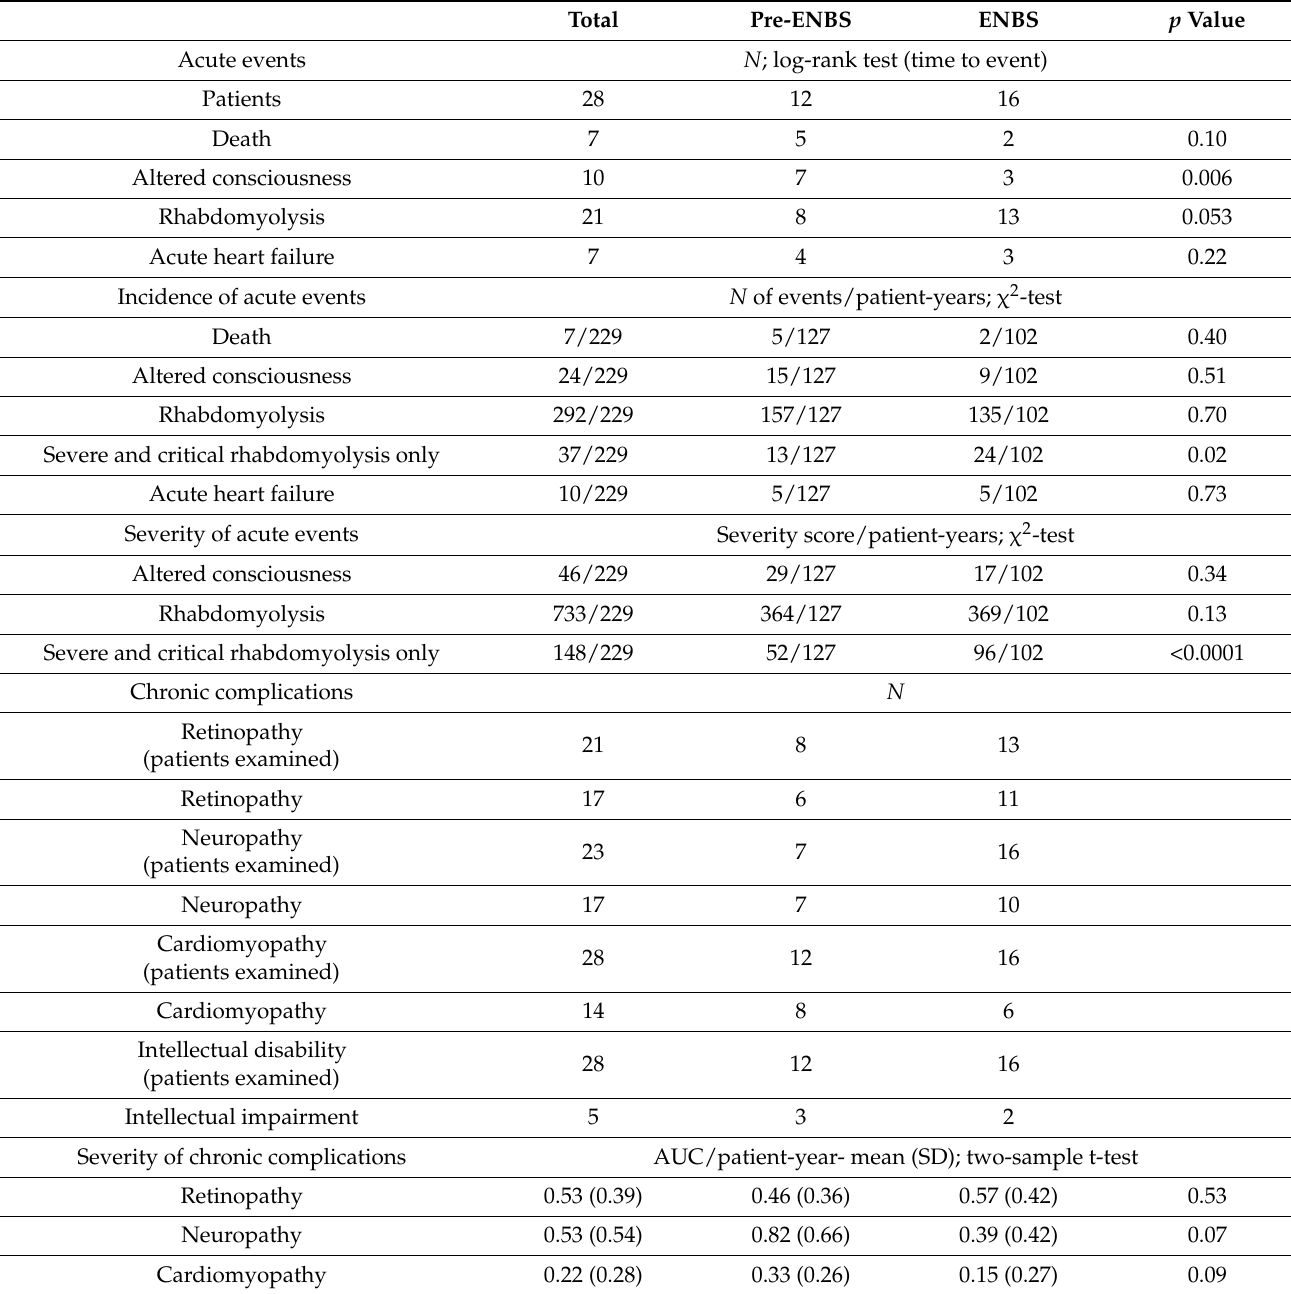
Table 2. Acute events, chronic complications, and their severity in patients diagnosed with LCHADD/MTPD before and after